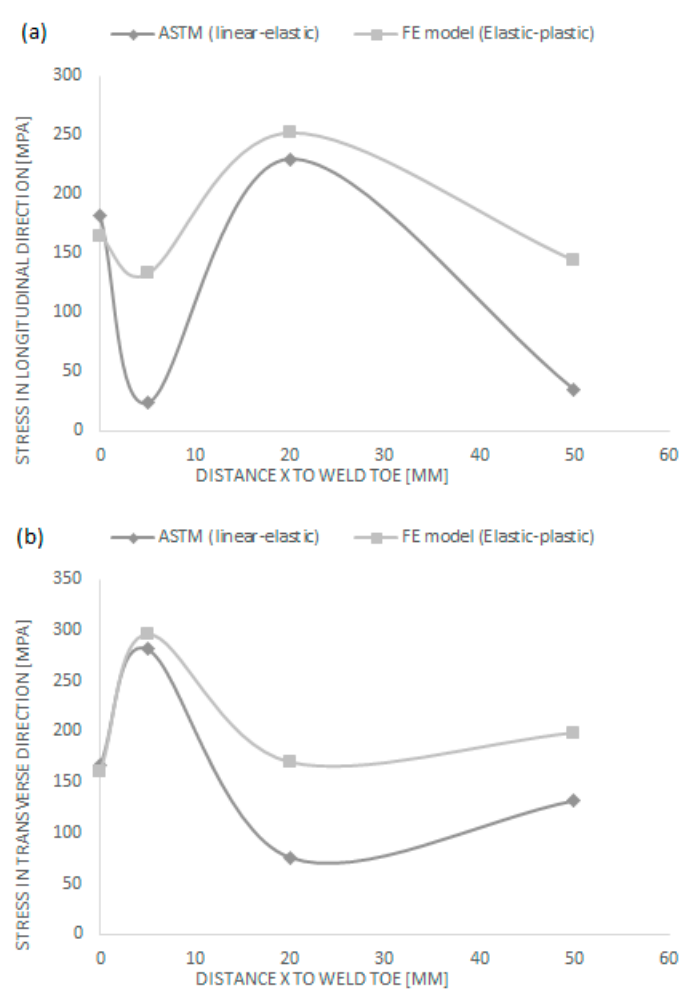
Figure 14. Comparison of residual stress distribution on the bottom of the deck plate between ASTM and the 3D model in the longitudinal ( a ) and transverse ( b ) directions.